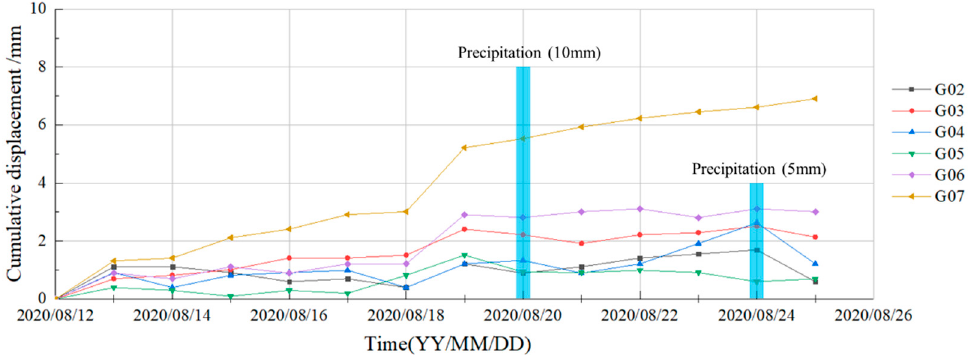
Figure 10. Deformation time series of GNSS stations on the Zhongbao landslide.